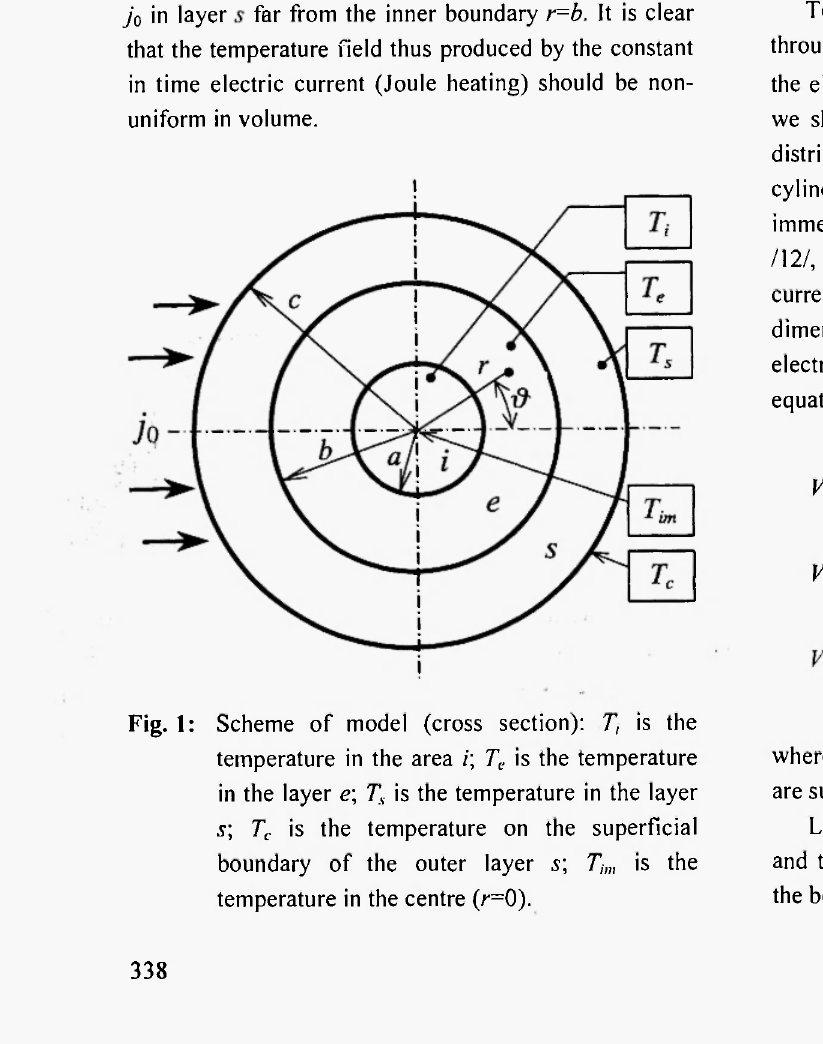
Fig. 1: Scheme of model (cross section): T, is the temperature in the area /; T c is the temperature in the layer e; T s is the temperature in the layer s; T c is the temperature on the superficial boundary of the outer layer s\ T im is the temperature in the centre